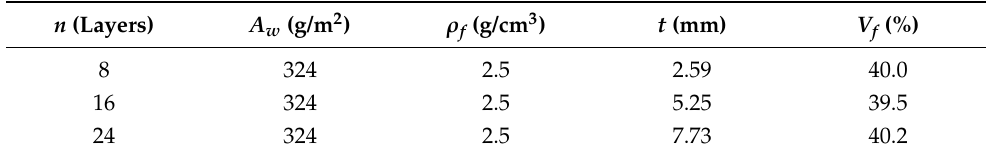
Table 1. The estimated fiber volume fraction.